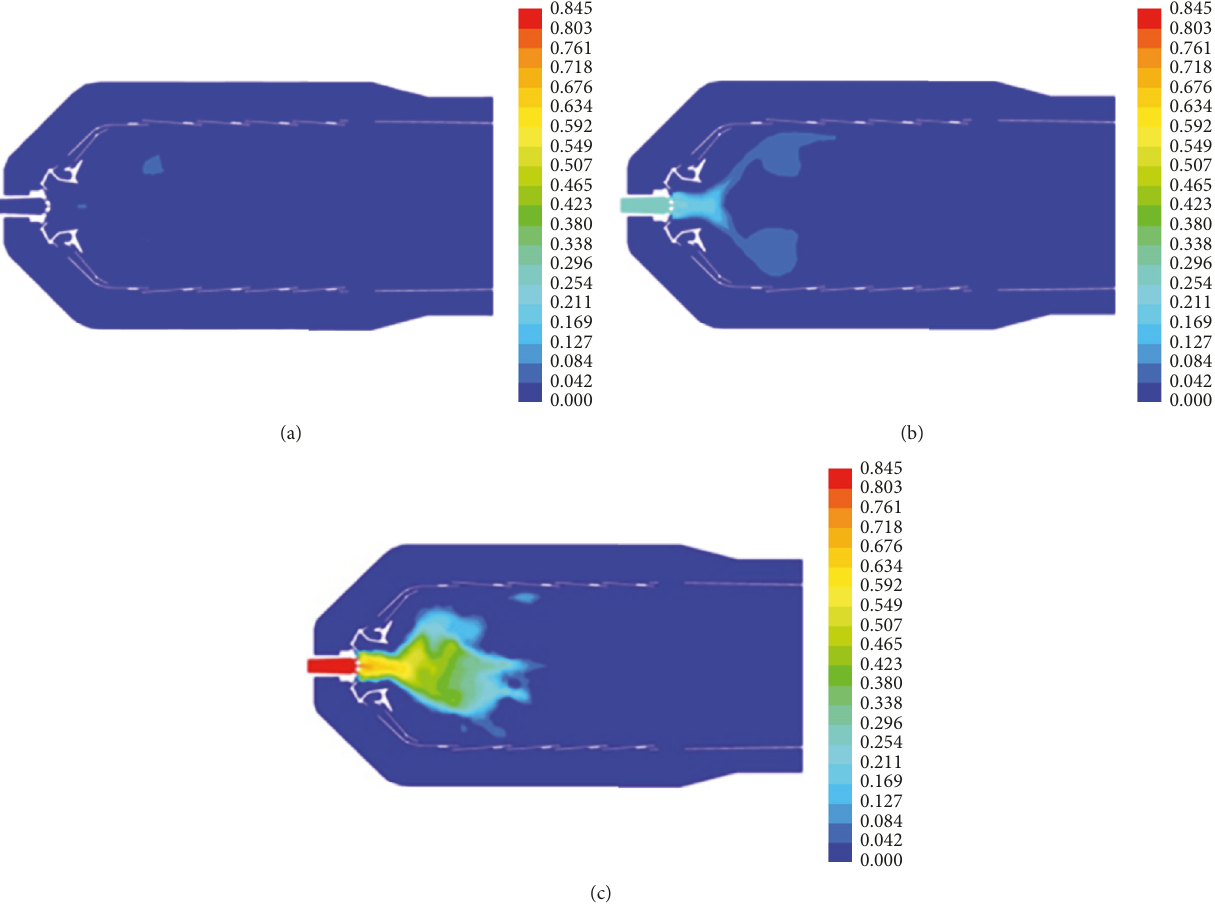
Figure 9: Distribution of CO mass fractions in the longitudinal section of the combustor: (a) variant 1; (b) variant 2; (c) variant 3.